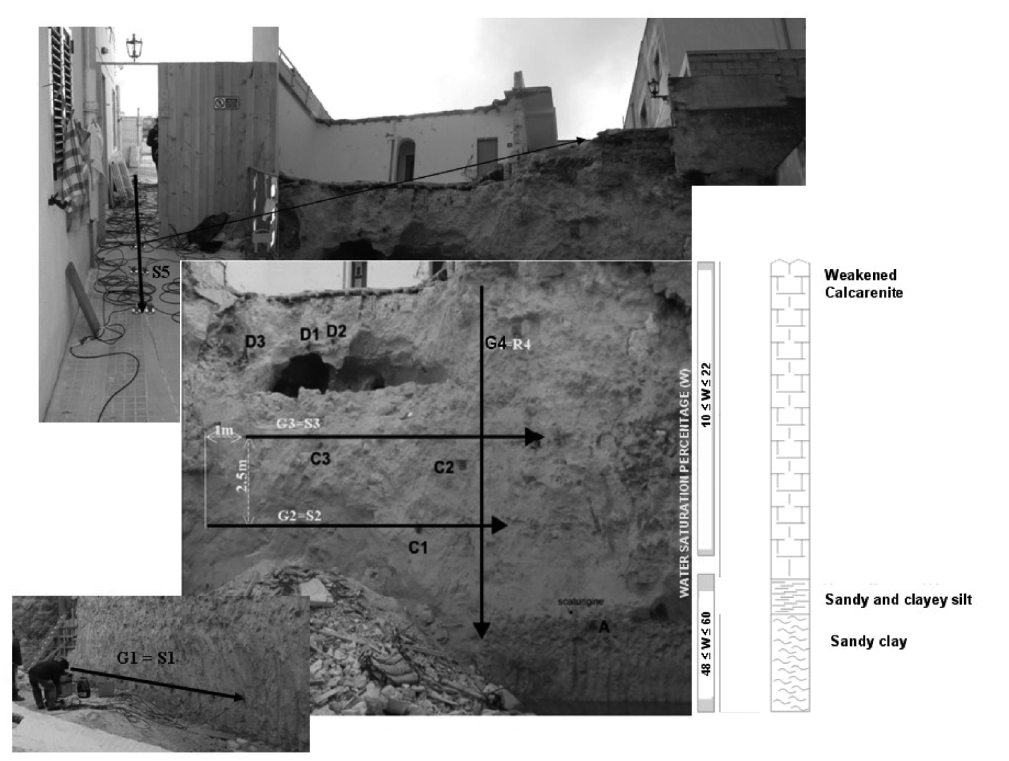
Fig. 3. Exposed rock face in Otranto with stratigraphy and the geophysical profiles